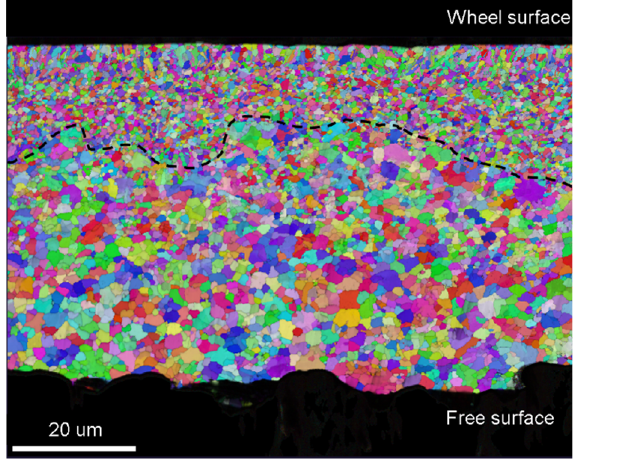
(FEG zone after RS), and between 1 µm and 4.7 µm in the top layer (CEG zone after RS).